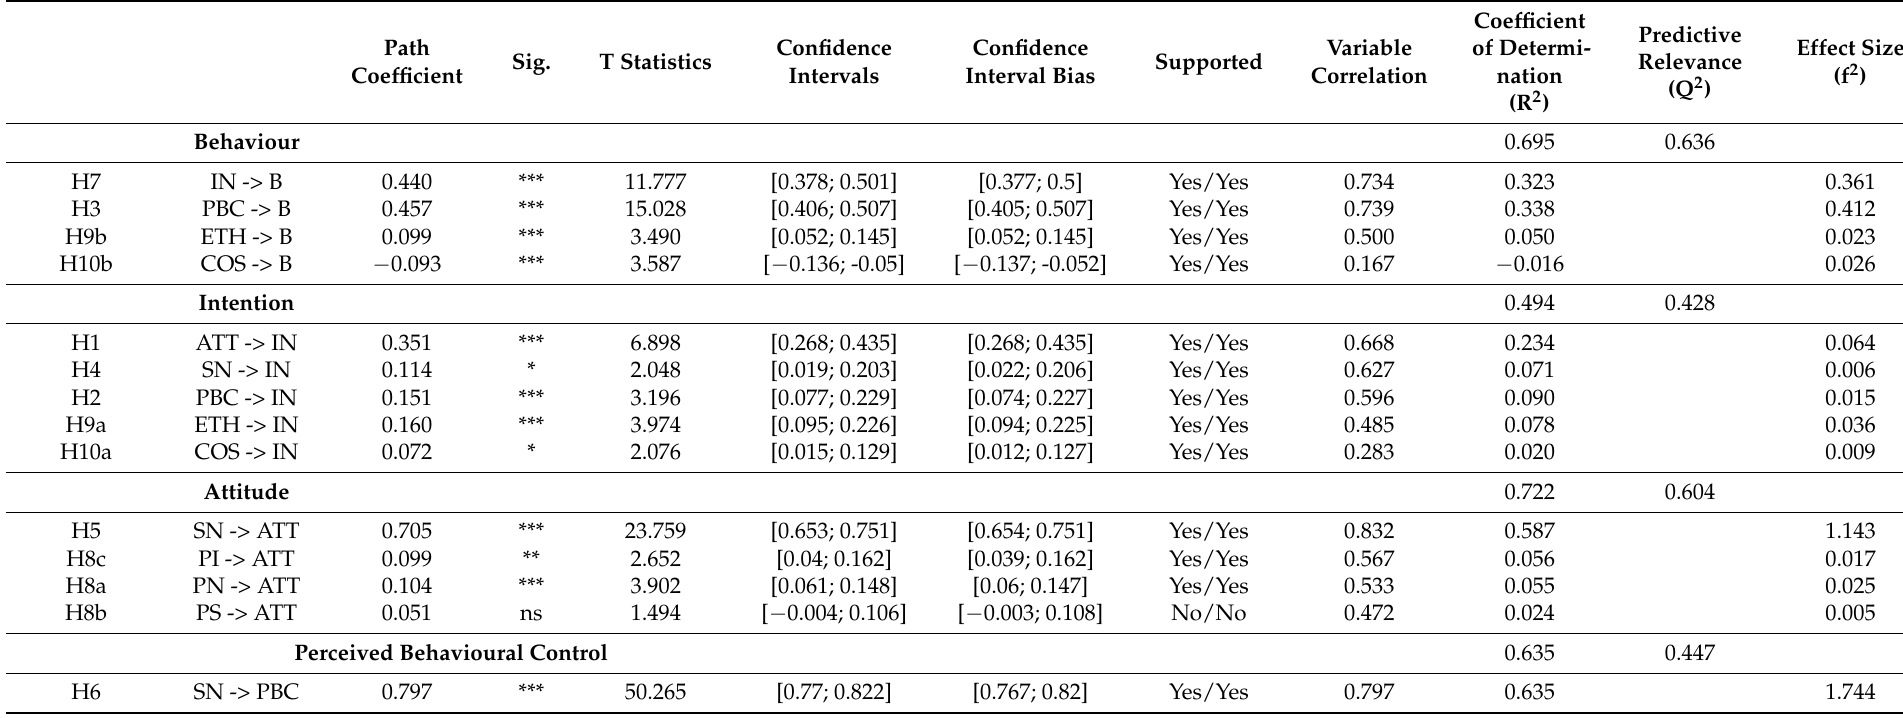
Table 4. Results of the hypothesis test, Variance Breakdown, Predictive Relevance redundancy and Effect size. * p < 0.5; ** p < 0.1; ***, p < 0.01; ns: non-significant. Path Sig. T Statistics Coefficient